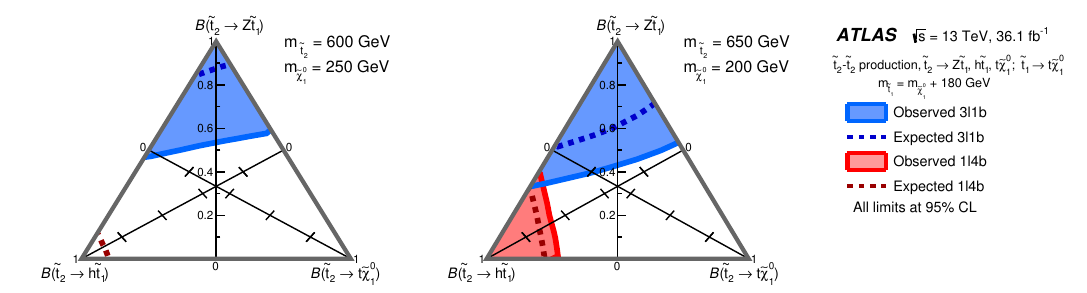
Figure 7. Exclusion limits at 95% CL from the analysis of 36 : 1 fb (cid:0) 1 of 13 TeV pp collision data as a function of the ~ t 2 branching ratio for ~ t 2 ! ~ t 1 Z , ~ t 2 ! ~ t 1 h and ~ t 2 ! t ~ (cid:31) 0 1 . The blue and red exclusion regions correspond to the 3 ‘ 1 b and 1 ‘ 4 b selections respectively. The limits are given for two di(cid:11)erent values of the ~ t 2 and ~ (cid:31) 0 1 masses. The dashed lines are the expected limit and the solid lines are the observed limit for the central value of the signal